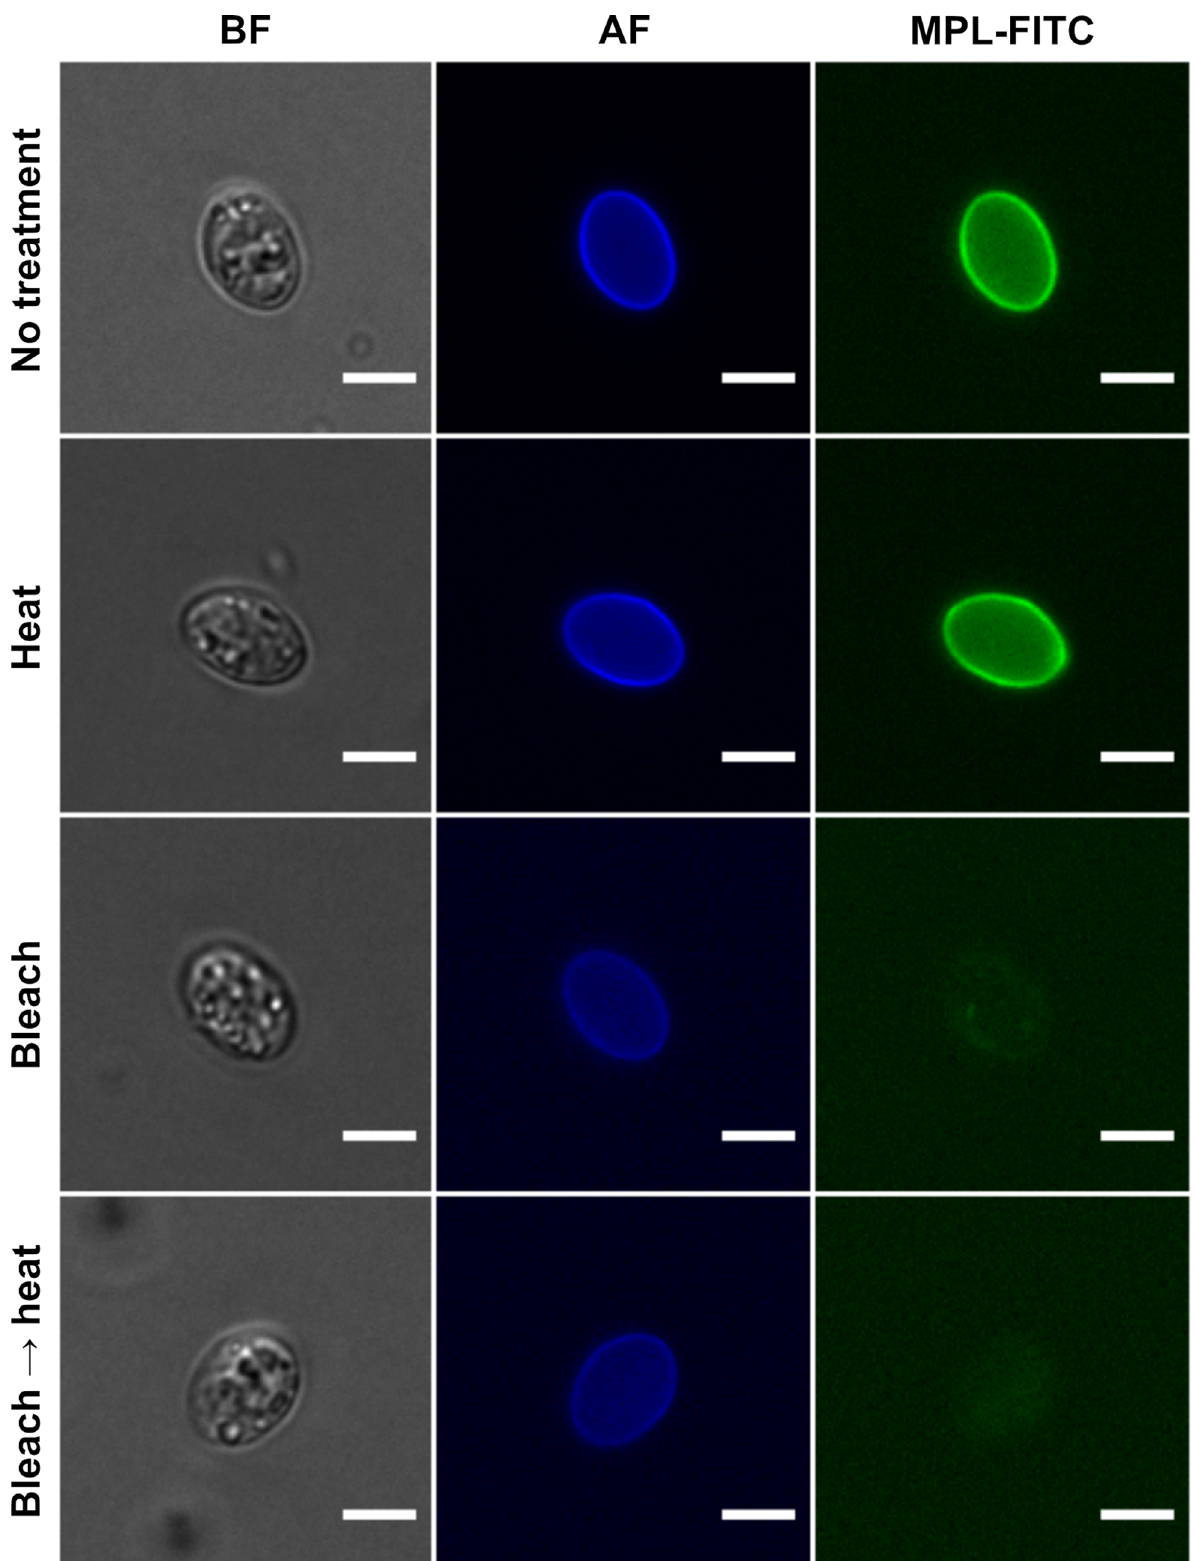
Figure 3. Maclura pomifera lectin-binding pattern of the wall of untreated, bleached and/or heated free Toxoplasma gondii sporocysts. BF, bright fi eld; AF, auto fl uorescence; MPL-FITC, Maclura pomifera coupled to FITC. Bar represents 5 l